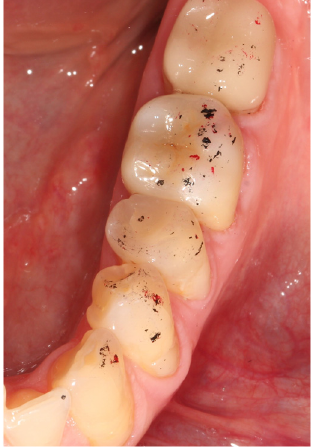
Figure 3. Participant with first lower left molar restored by study crown made of zirconia. Static occlusion contacts were visualized using black occlusion foil, dynamic contacts using red occlusion foil.